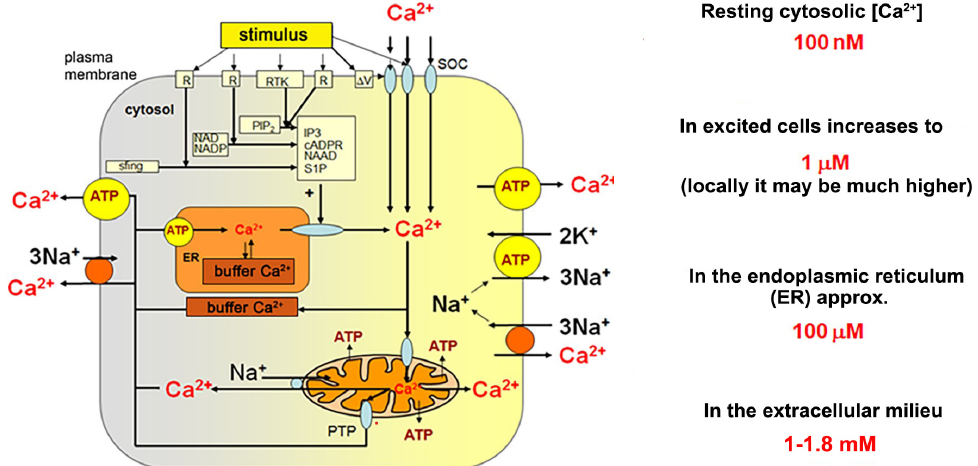
Figure 1. Key elements of cellular calcium homeostasis in an animal cell. (According to Berridge et al. (2000) [40] Modified).